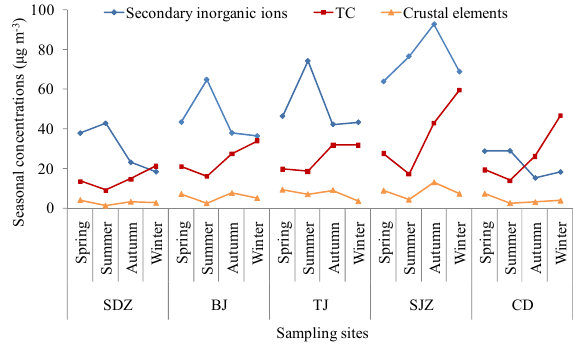
Figure 5. Seasonal concentrations of secondary inorganic ions, TC, and crustal Fig. 5. Seasonal concentrations of secondary inorganic ions, TC, elements at five sites. and crustal elements at the five